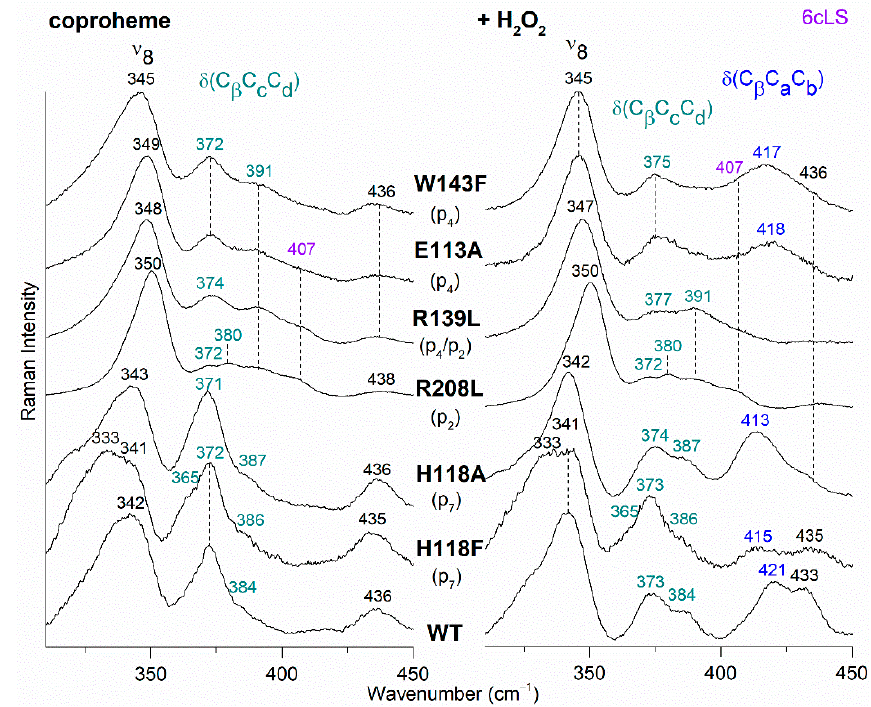
Figure 7. RR spectra in the low wavenumber region of WT and selected variants of Cd ChdC complexed with coproheme before ( Left ) and after H 2 O 2 titration ( Right ). In brackets, the propionate, whose corresponding H-bond is removed by mutation, is reported. The band at 407 cm − 1 due to a 6cLS species [9] is reported in violet, while the δ (C β C c C d ) propionate and the δ (C β C a C b ) vinyl bending modes are in green and blue, respectively.